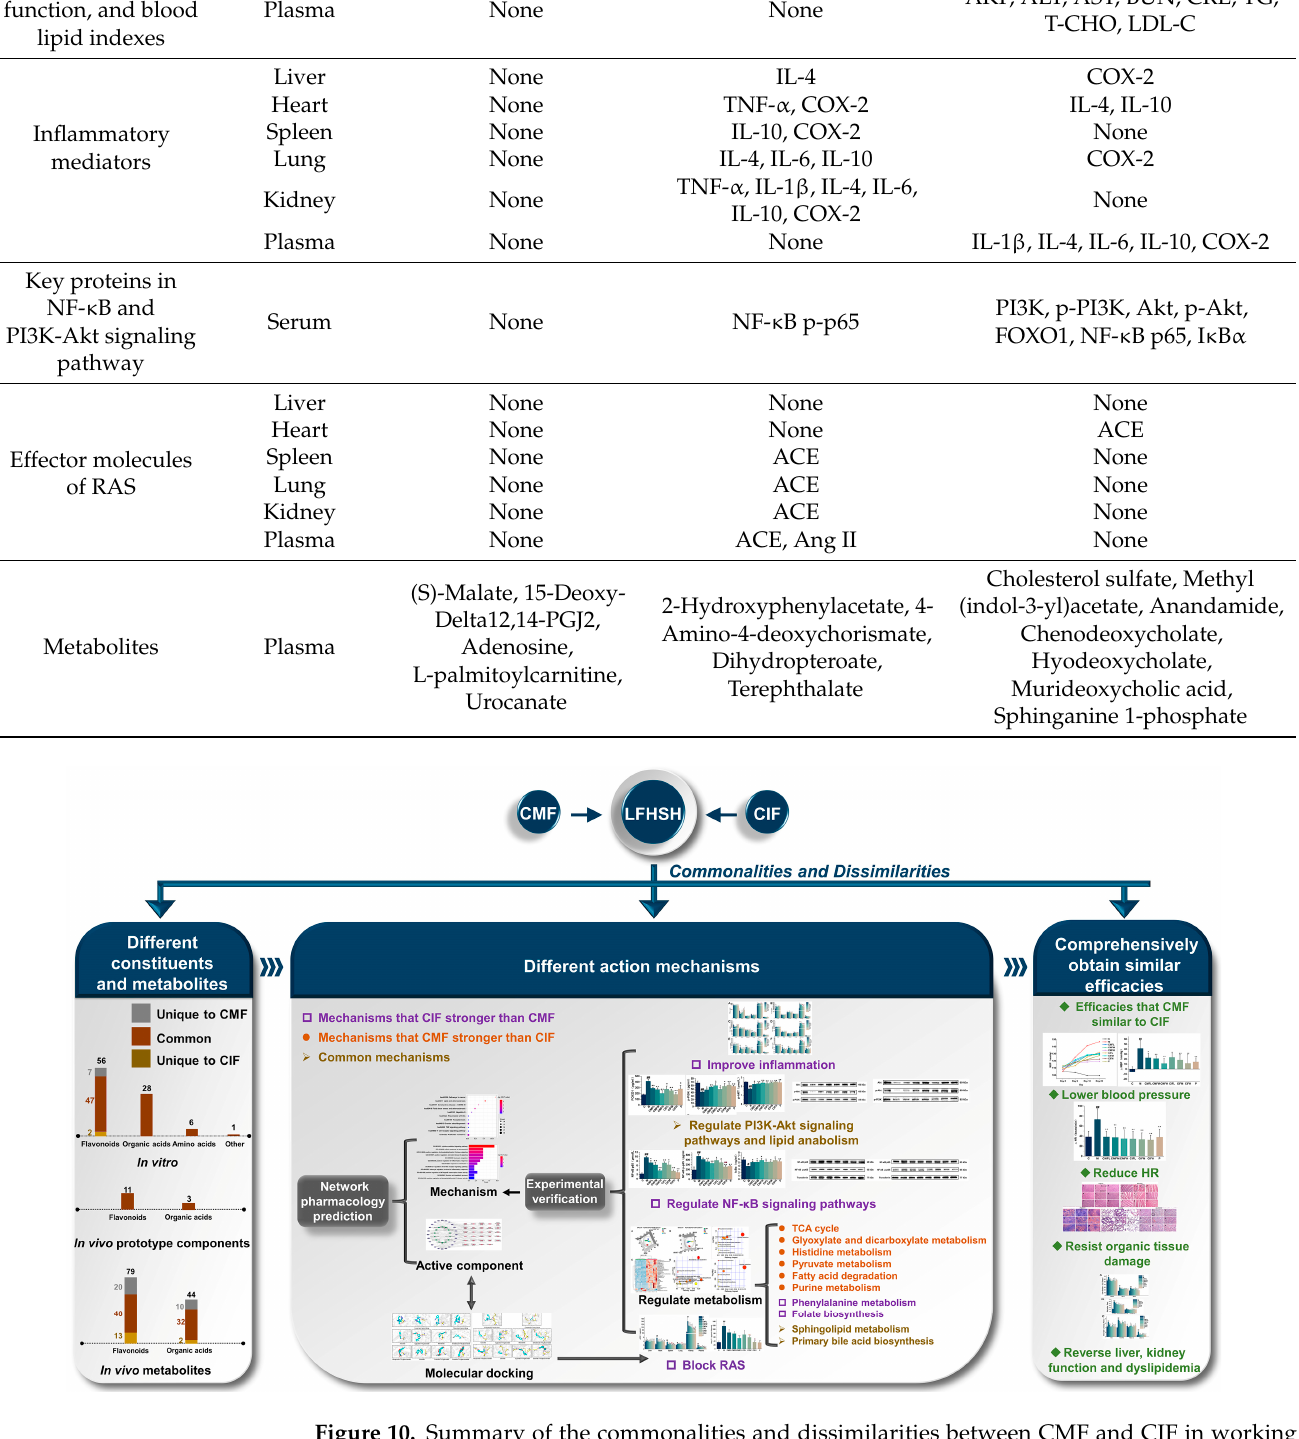
Figure 10. Summary of the commonalities and dissimilarities between CMF and CIF in working agaisnt LFHSH.